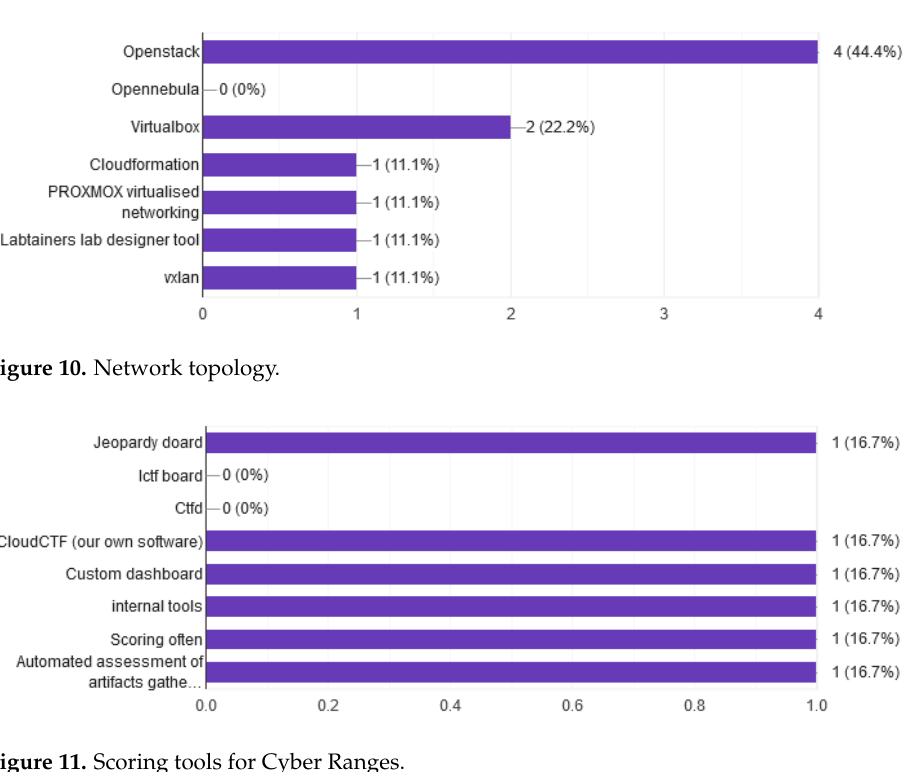
Figure 11. Scoring tools for Cyber Ranges.